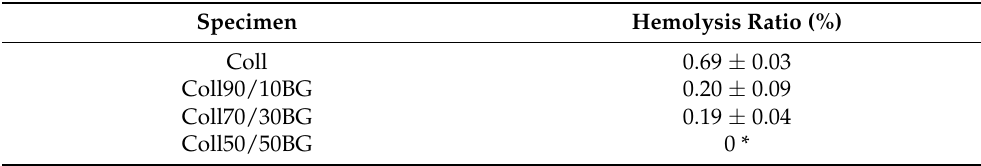
Table 7. Hemolysis ratio calculated for collagen and collagen/ β -glucan films.